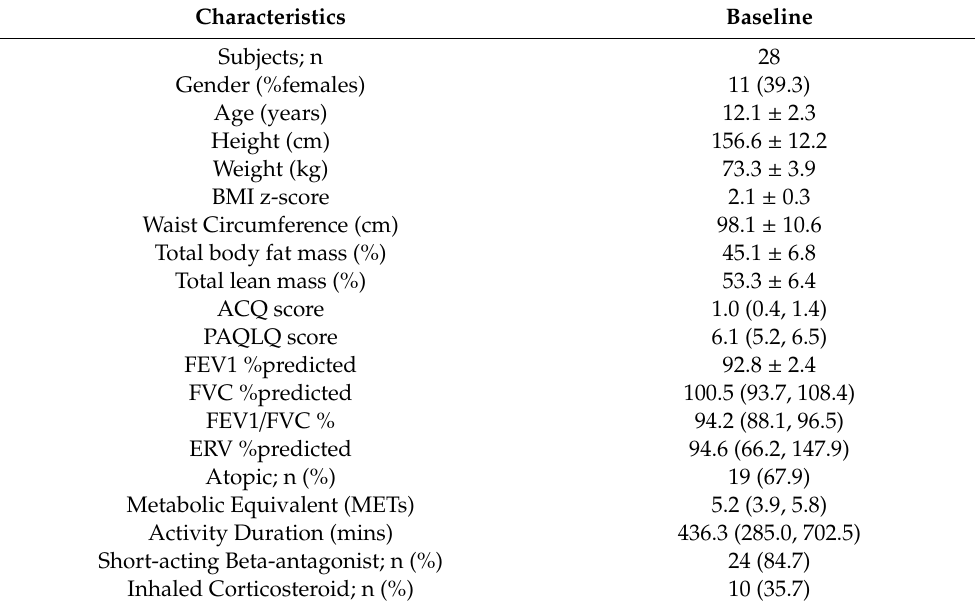
Table 1. Subject characteristics at